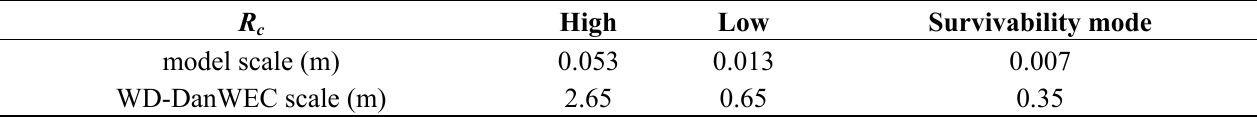
Table 2. Crest levels used in the